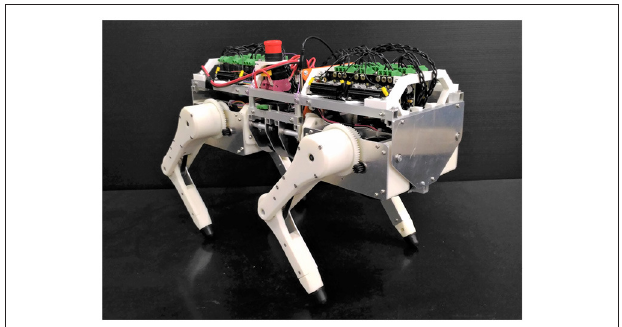
FIGURE 1 | Snapshot of a quadruped robotic platform that can reproduce muscle characteristics and reflexes.